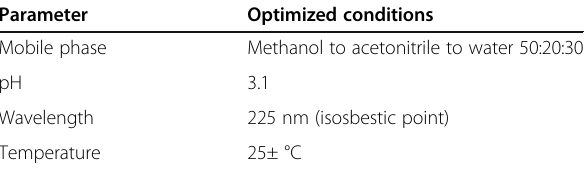
Table 1 Chromatographic conditions